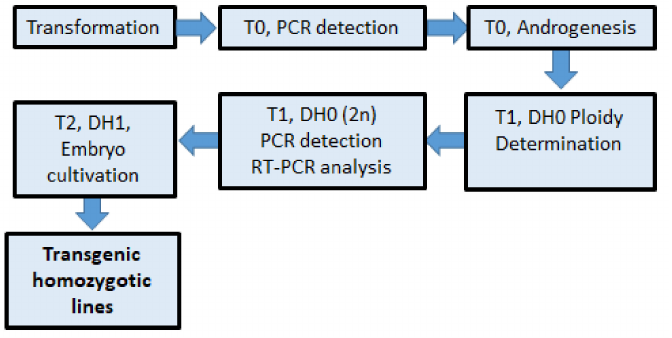
Figure 1. Scheme for rapid production of transgenic homozygous barley